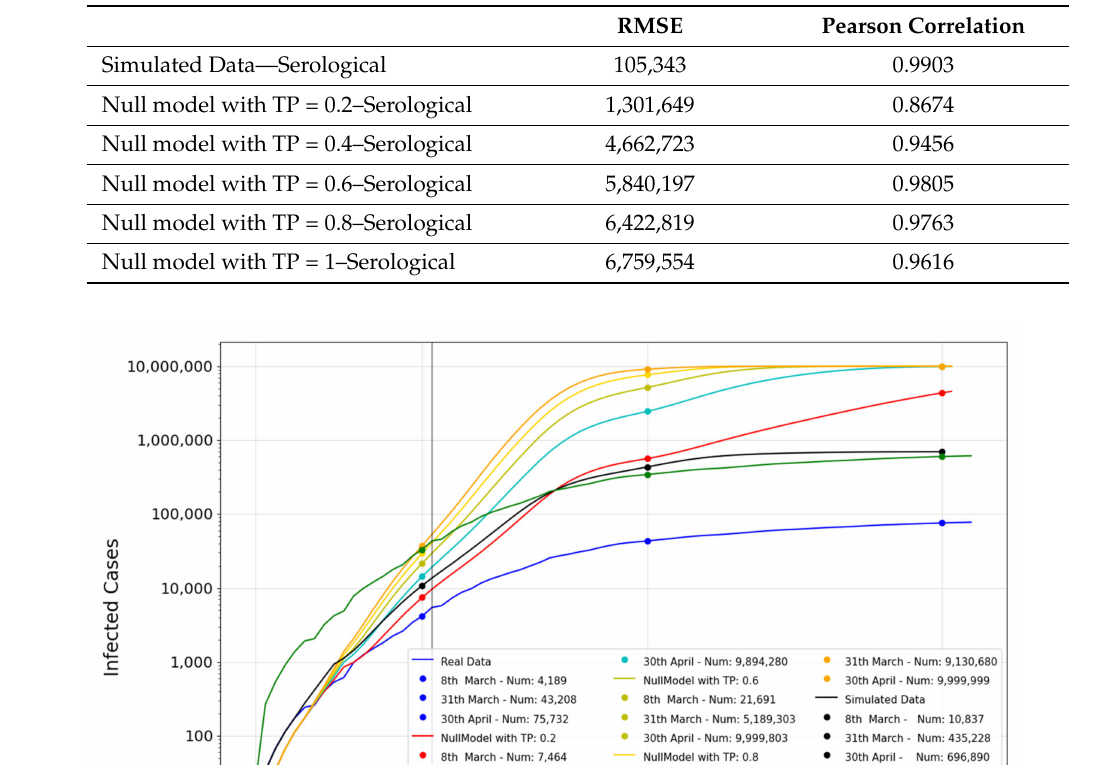
Table 2. Comparison of our model to the null models in terms of root mean squared error (RMSE) and Pearson correlation n.